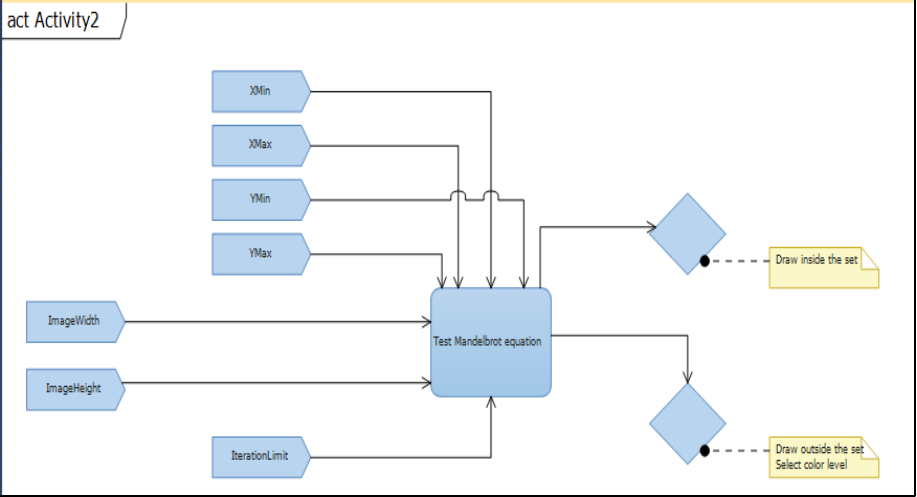
Figure 2. General application architecture of the sequential Mandelbrot algorithm.